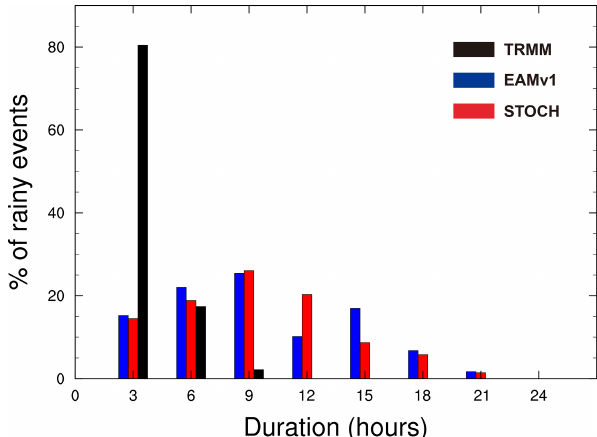
Figure 7. Histogram of the percentage frequency of total rainy events as a function of their duration using 3-hourly data (con- ditional probability of rainfall given rainfall from previous times) from TRMM (black), EAMv1 (blue) and STOCH (red) for the threshold rainfall rate of 1mmd − 1 over the